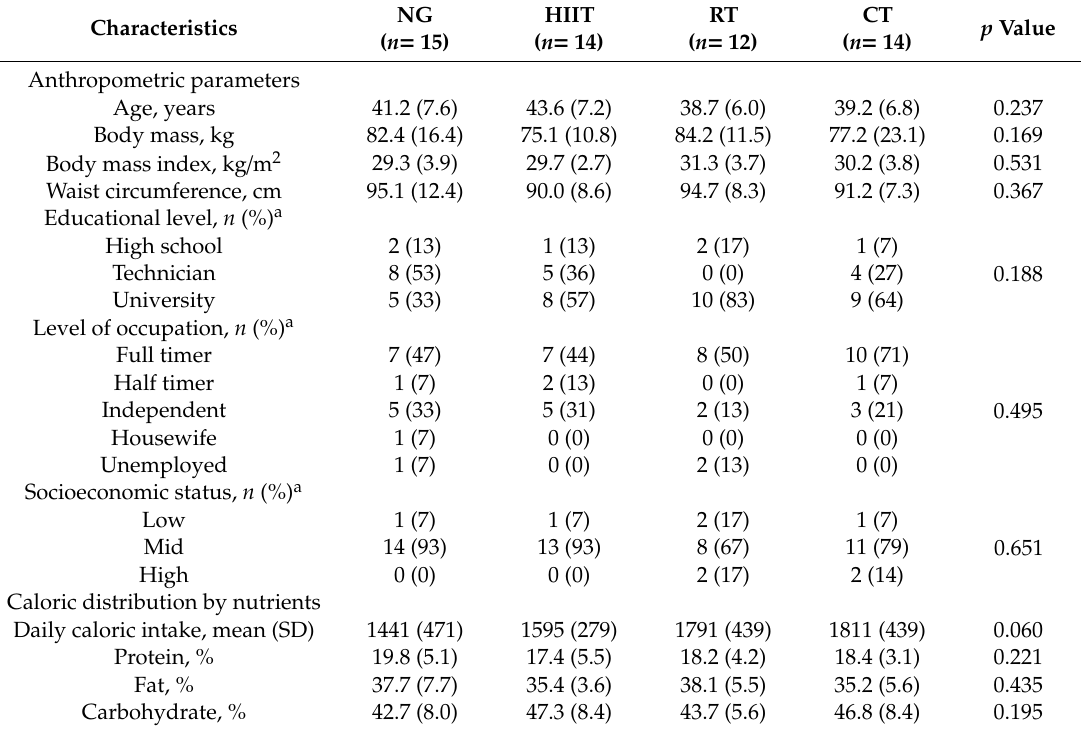
Table 1. Baseline characteristics of study